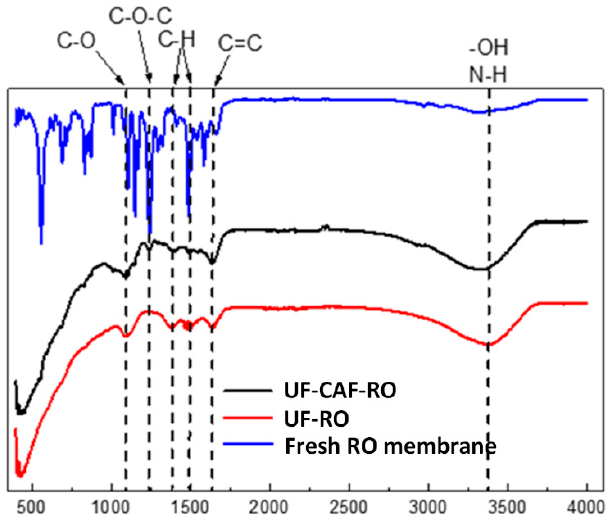
Table 3. Comparative analysis of the inorganic ions fouled on the RO membranes in the 2nd evalu- ation.